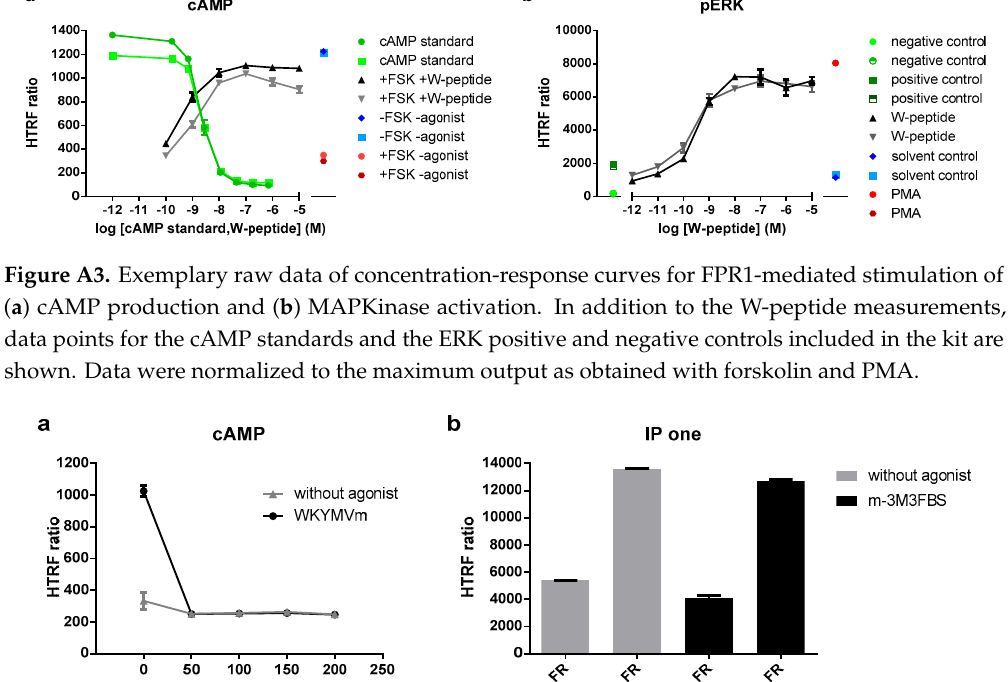
Figure A2. Concentration-response curves for FPR1-mediated stimulation of cAMP production. None of the agonists increased intracellular cAMP levels, in line with the reported FPR1-mediated activation of G α i . Mean response ± SEM, n 3.